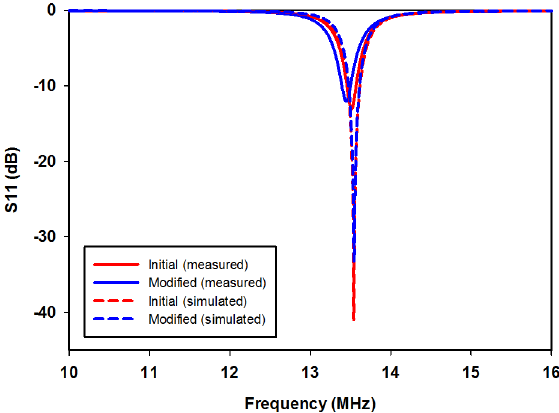
Fig 5. Reflection coefficients of planar square